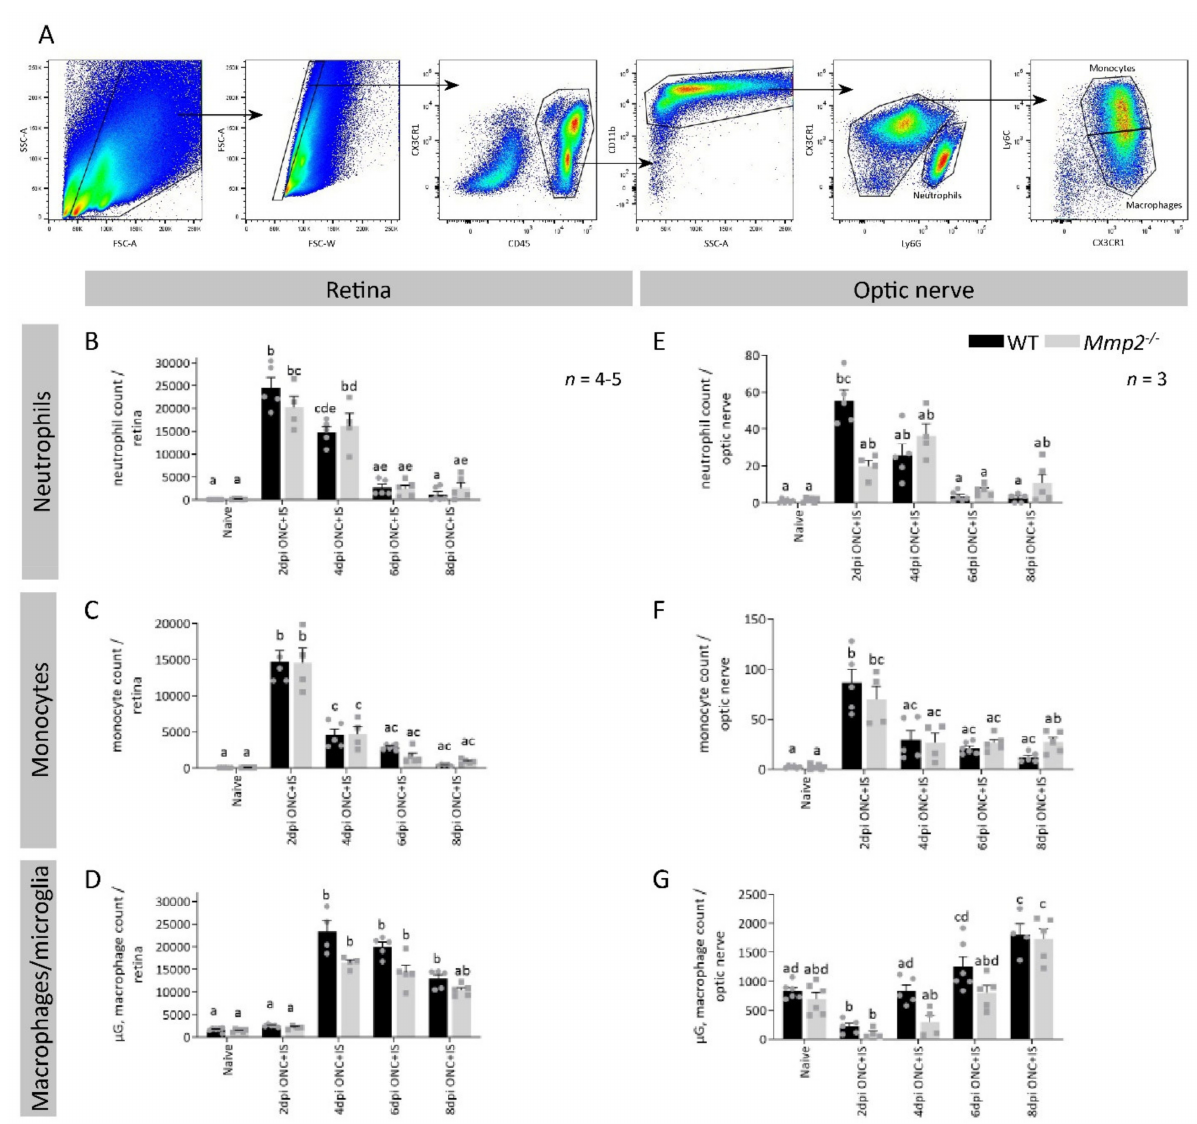
Figure 6. The effect of MMP2 deficiency on the resident and infiltrating myeloid cells in the retina and optic nerve. ( A ) Gating strategy applied to all retinal and optic nerve samples for both genotypes in naive mice and at 2, 4, 6 and 8 dpi ONC + IS. The single cell population was identified based on cell size and complexity/granularity (respectively FSC and SSC). First, all leukocytes were gated based on CD45 expression and then the myeloid cells were selected based on CD11b expression. The different myeloid cell populations of interest were identified as neutrophils (referred to as Ly6G + , CX3CR1 - ), monocytes (referred to as Ly6G - , CX3CR1 + , Ly6C + ) and microglia/macrophages (referred to as Ly6G - , CX3CR1 + , Ly6C - ). ( B – G ) Compiled flow cytometry data show similar trends for all cell populations at all time points between Mmp2-/- and WT mice in both the retina ( B – D ) and optic nerve ( E – G ). Data are shown as mean ± SEM. Repeated measures two-way ANOVA followed by Tukey’s multiple comparisons test, statistical significance between different time points and conditions is indicated using different